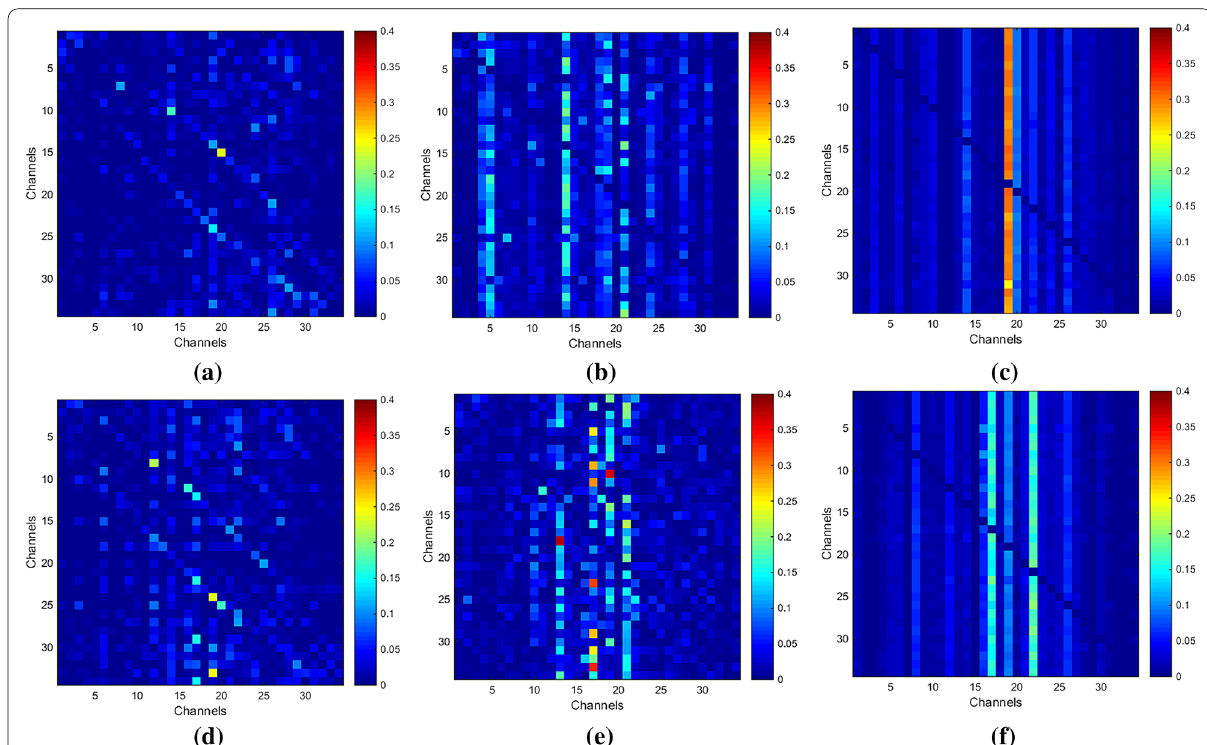
Fig. 8 AMs of ‘k3b’ in α frequency band a m m 3 for ‘RH’ =